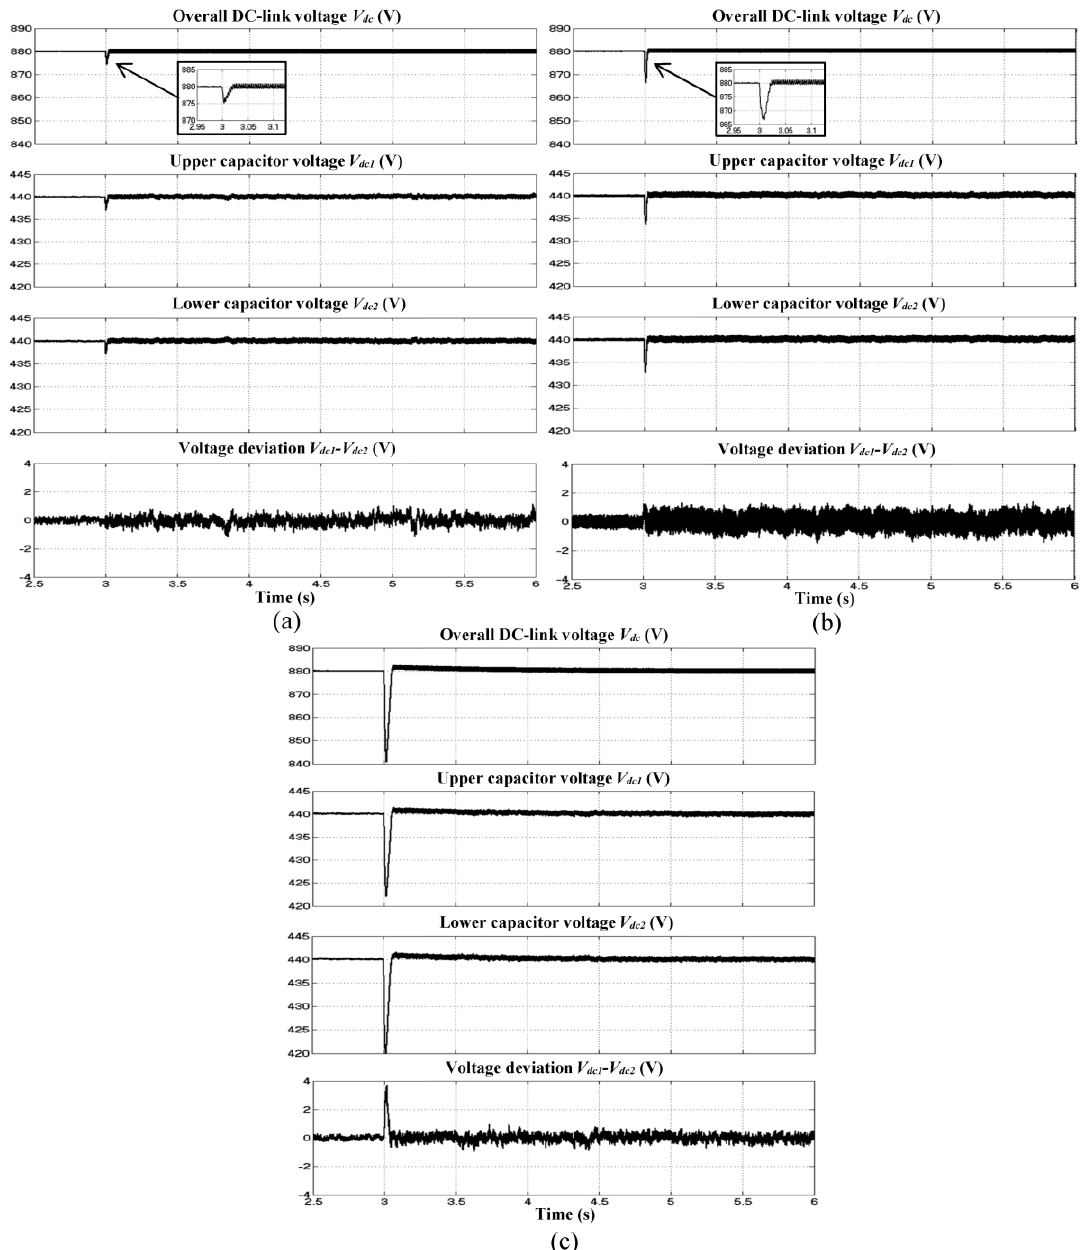
Figure 1. Simulation results of SAPF which include overall DC-link voltage 𝑉 𝑑𝑐 , splitting DC-link capacitor voltages ( 𝑉 𝑑𝑐1 and 𝑉 𝑑𝑐2 ) and neutral-point voltage deviation ( 𝑉 𝑑𝑐1 − 𝑉 𝑑𝑐2 ) for dynamic-state condition of inductive to resistive load obtained using ( a ) the proposed algorithm with IED control; and ( b ) the conventional algorithm with FLC and ( c ) PI techniques.